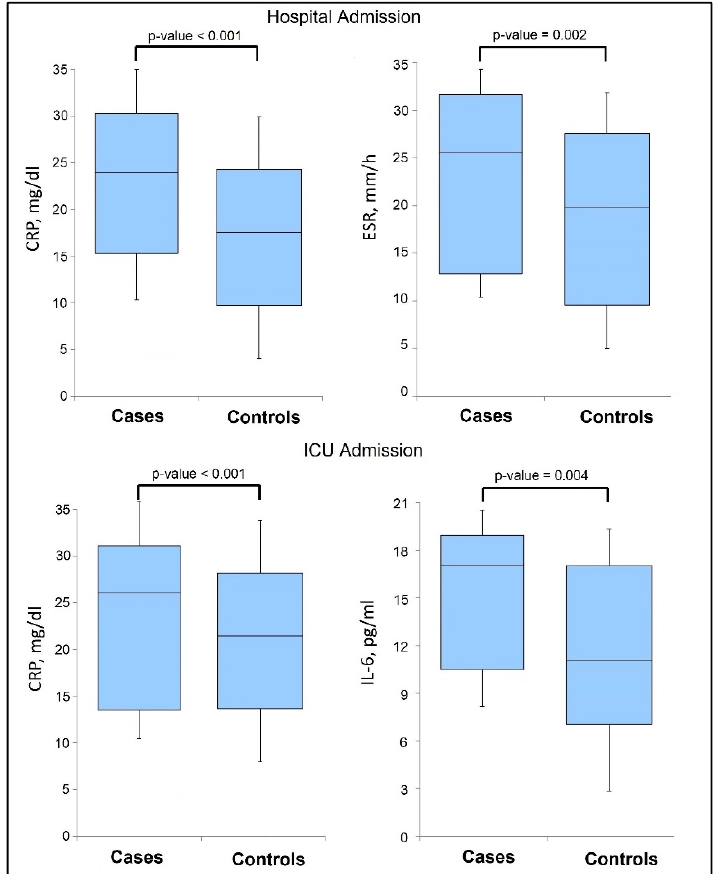
Figure 1. Boxplot of significant findings in biological parameters at hospital admission and ICU admission. The upper boxes present the median and IQR values of CRP and ESR at hospital admission. The lower boxes present the median and IQR values of CRP and IL-6 at ICU admission.